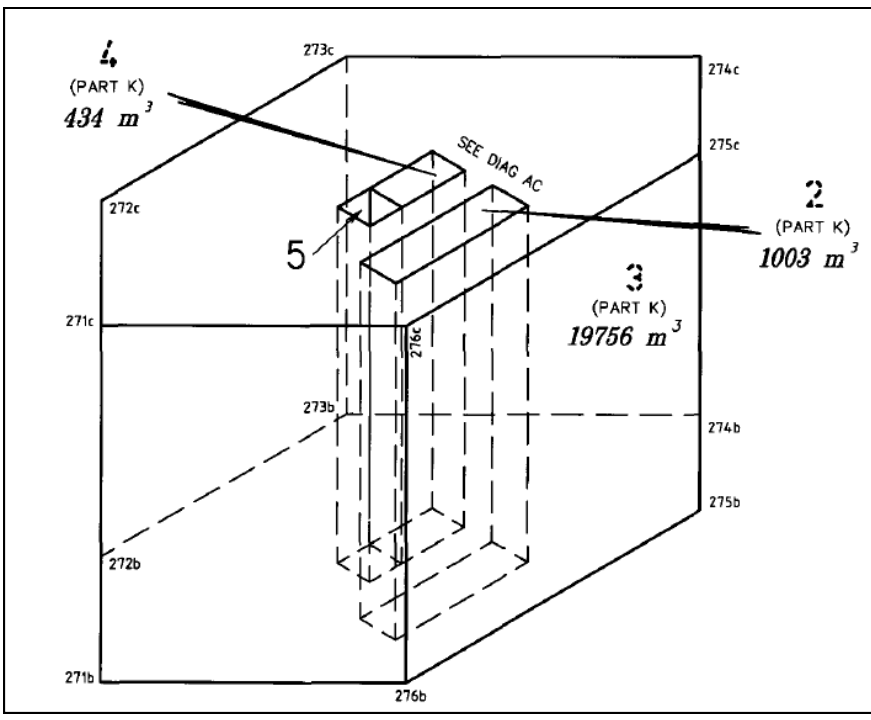
Figure 6. Excerpt from plan SP217742 showing part of Lot 3 (part K).